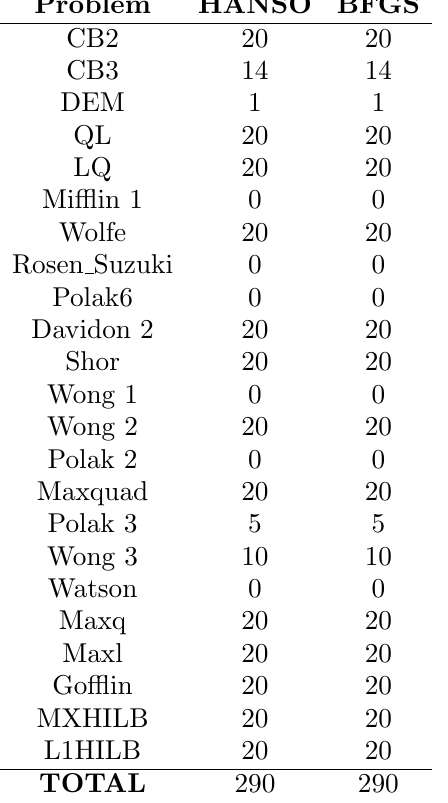
Table 3. Number of convex prob- lems solved